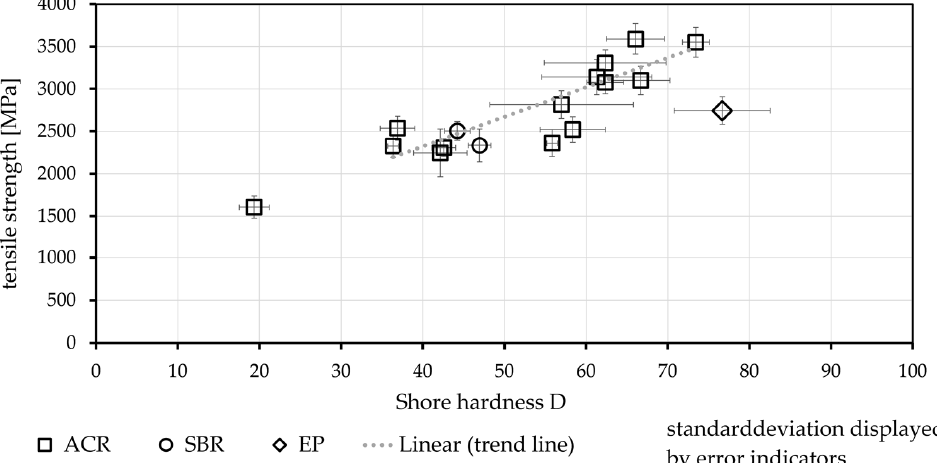
Figure 12. Correlation between Shore hardness and tensile strength of textiles with varying cross sections, yarn materials and impregnation agents (mean values of 10–20).